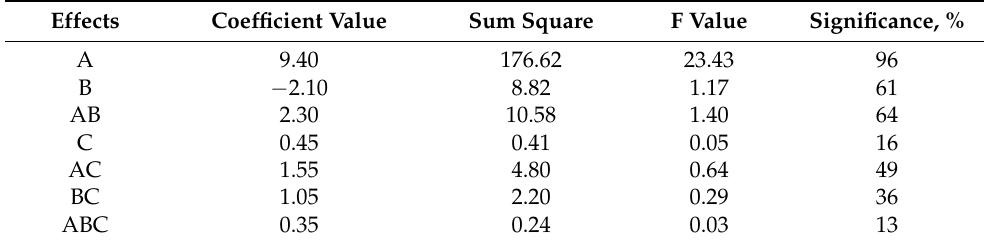
Table 7. ANOVA full factorial design (A: thiourea, g/L; B: Fe 3+ , % w / v ; C: temperature, ◦ C).